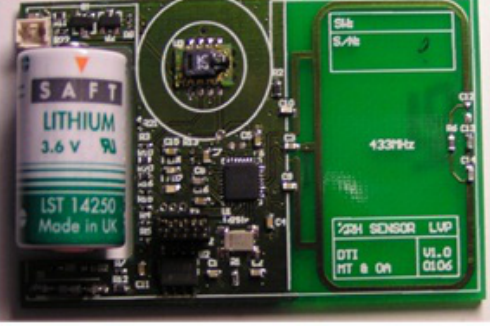
Figure 2. The designed sensor